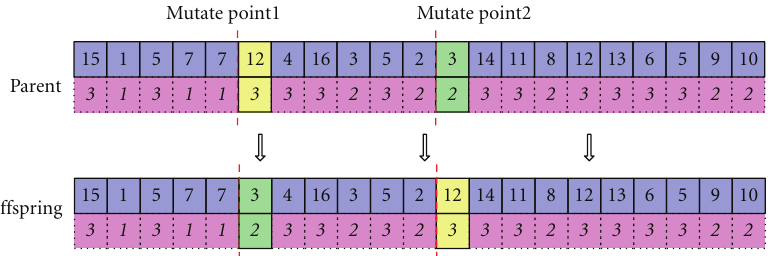
Figure 7: The mutation operator: an